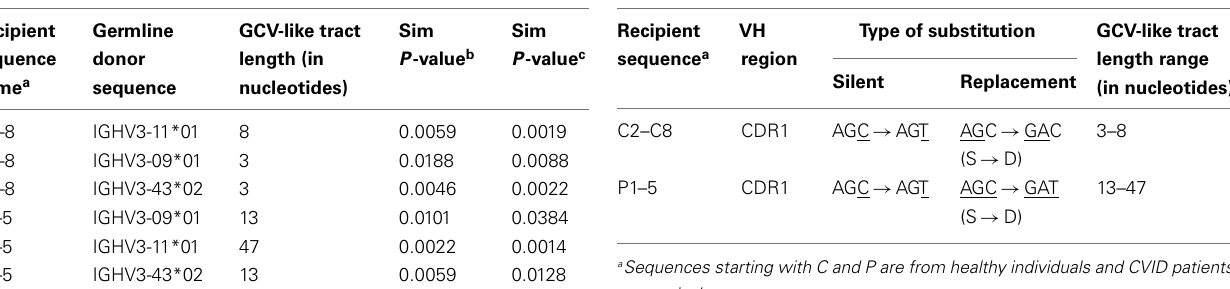
Table 2 | Characteristics of GCV-like tracts predicted by GENECONV in rearranged IGHV3-23*01 gene sequences.